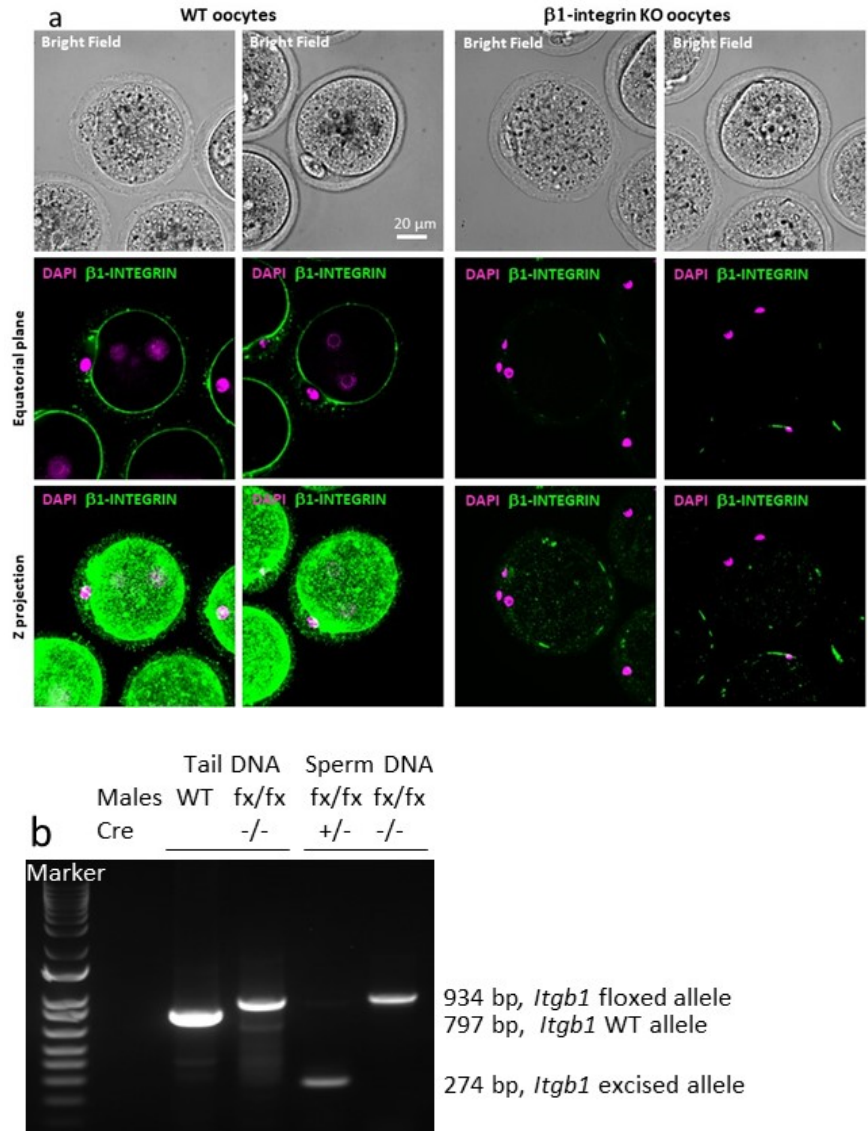
Figure 2. ( a ) Oocytes from Zp3-Cre − / − Itgb1 flox/flox (WT oocytes) females express integrin beta1 at their surface while there is no staining on oocytes from Zp3-Cre +/ − Itgb1 flox/flox (KO oocytes). ( b ) Itgb1 PCR on tail and sperm DNA. The same primers used gave 797 bp band on WT DNA, 934 bp in floxed (fx) tail DNA or Cre -negative sperm DNA and 274 bp on Cre -positive Itgb1 excised allele sperm DNA.